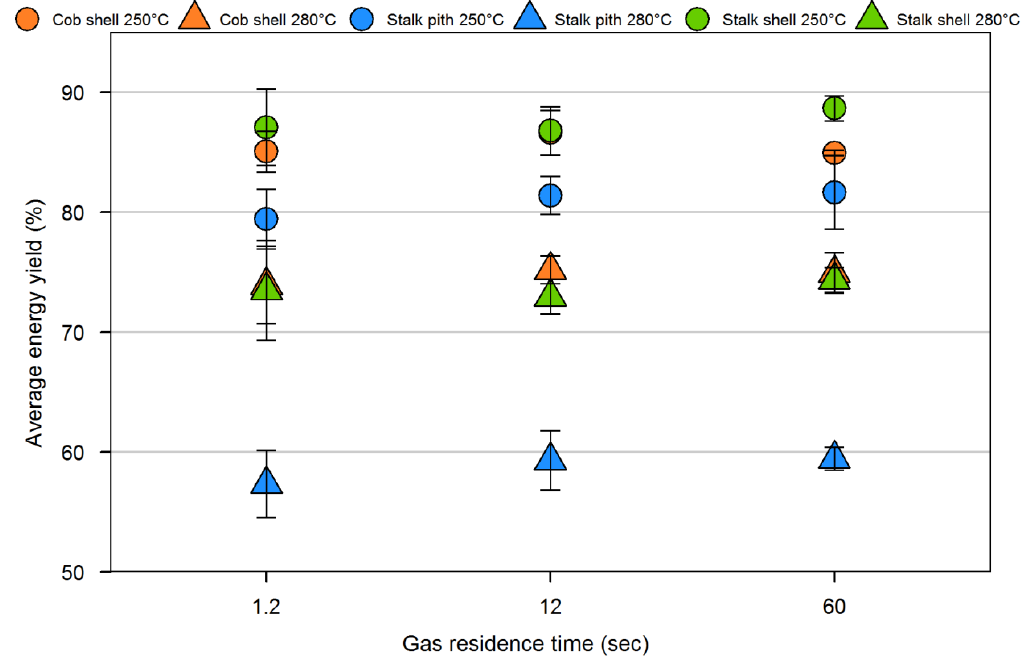
Figure 8. Average energy yield of torrefied stalk shell, stalk pith, and cob shell samples (error bar = standard